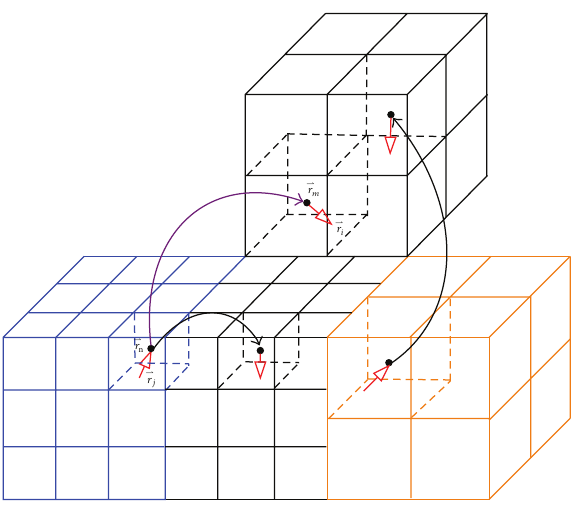
Figure 4: The process of aggregation, translation, and disaggrega- tion, where each “ ∙ ” represents the center of a bottom-layer box.